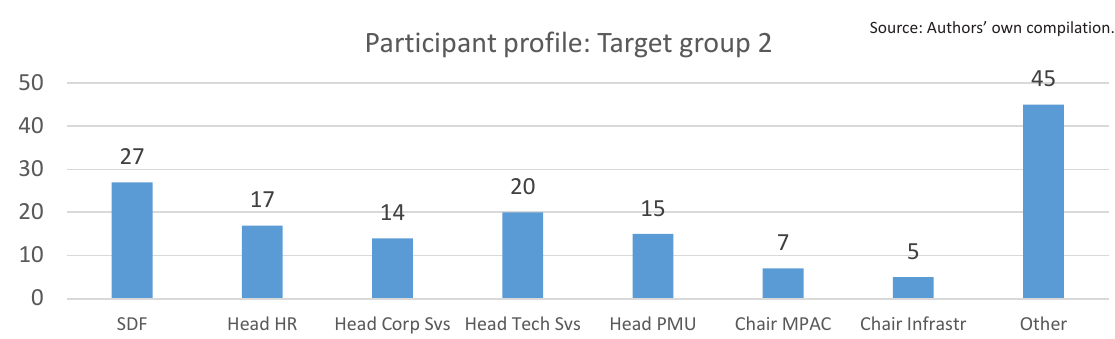
Figure 3. Profile of target group Participant profile: Target group 2